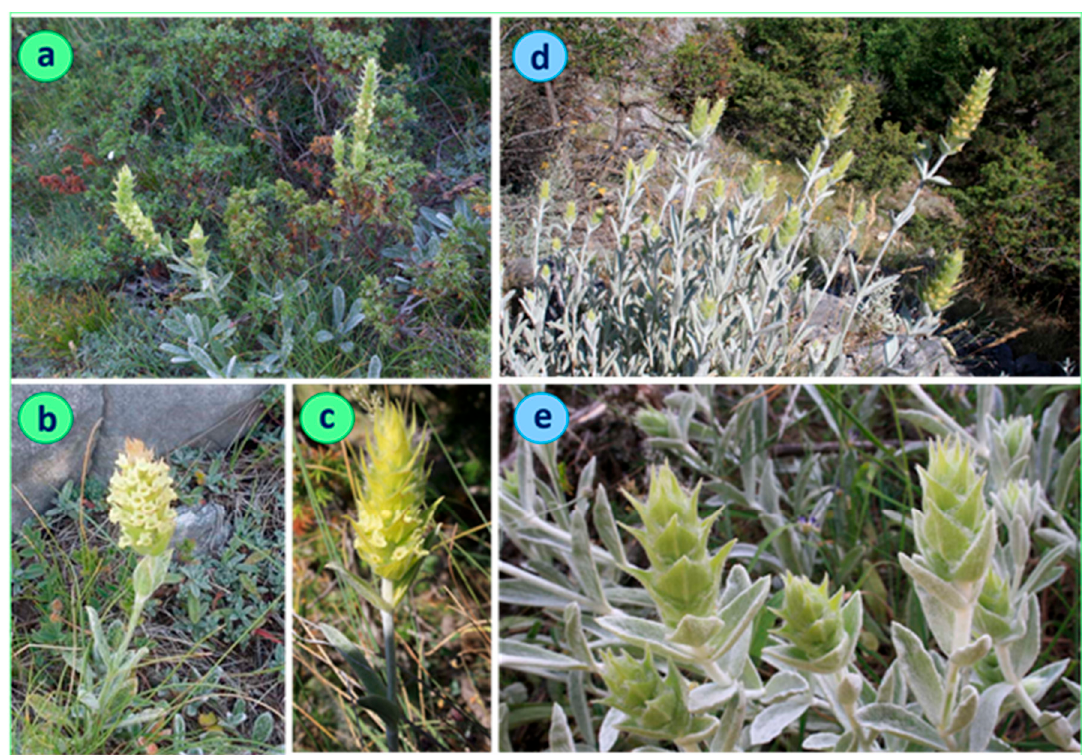
Figure 1. Sideritis scardica : live individuals from the Slavyanka Mountain ( a – c ) and Sideritis elica from Chervenata Stena ( d , e )—upper part of the plant.